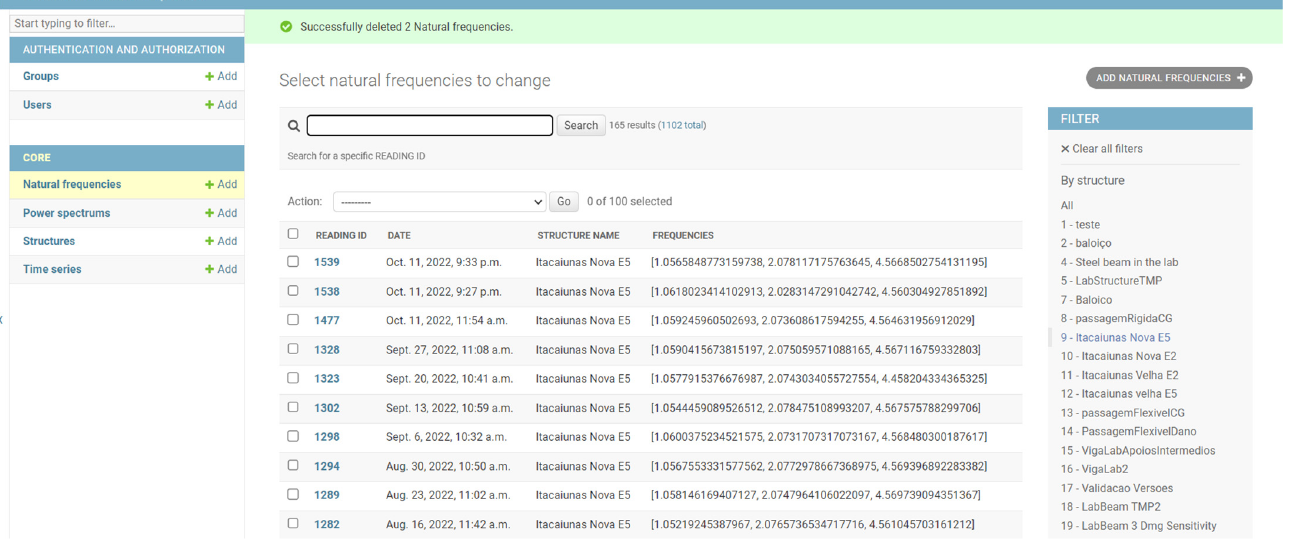
Figure 3. Backoffice administration of App4SHM.